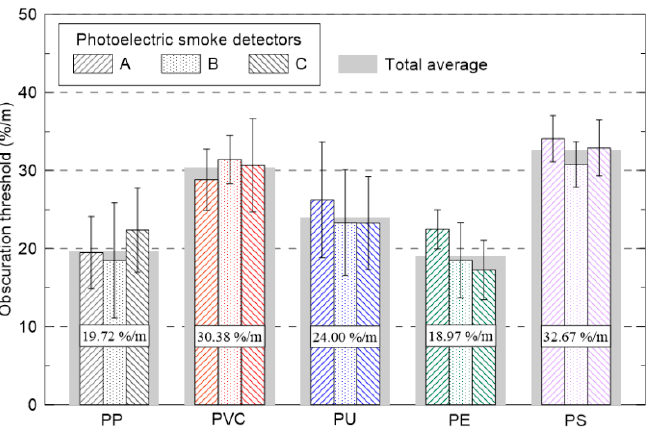
Figure 9. Comparison of obscuration thresholds with various polymer pellets (polypropylene (PP), polyvinyl chloride (PVC), polyurethane (PU), polyethylene (PE) and polystyrene (PS)) for the photoelectric detector models (A–C).